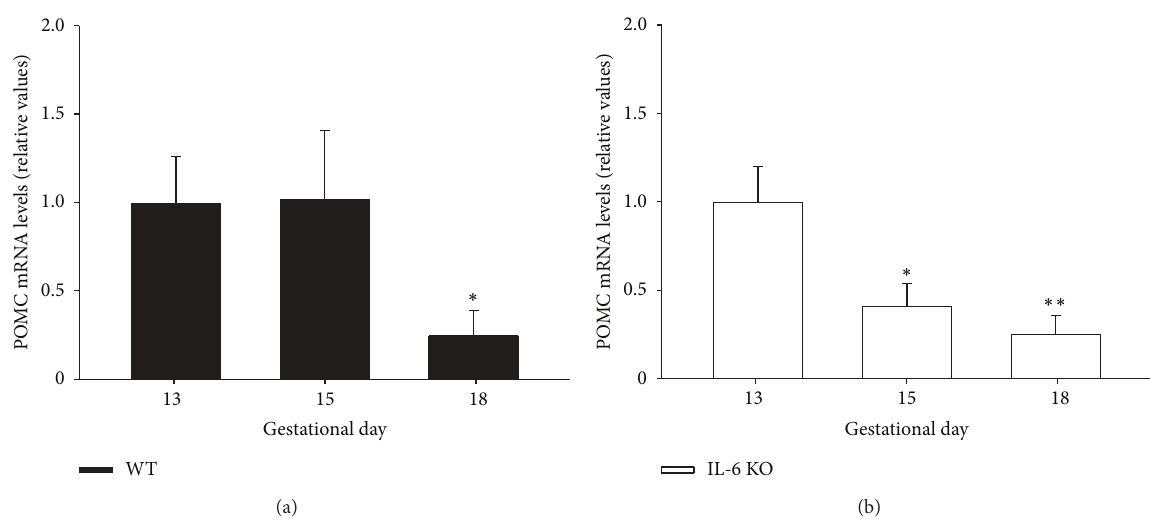
Figure 5: POMC mRNA expression in placenta of WT and IL-6 KO mice. 12-week-old WT and IL-6 KO mice were time-pregnant and placental POMC mRNA levels in (a) WT and (b) IL-6 KO mice at different pregnancy stages (13, 15, and 18 days) were assessed by real-time qPCR; 𝑛 = 5 - 6 . Within each genotype, relative mRNA levels were normalized to 13 days pregnant mice values as 1. Each value represents the mean ± SEM. One-way ANOVA: ∗ 𝑃 < 0.05 , ∗∗ 𝑃 < 0.01 versus 13 days pregnant mice of respective genotype.